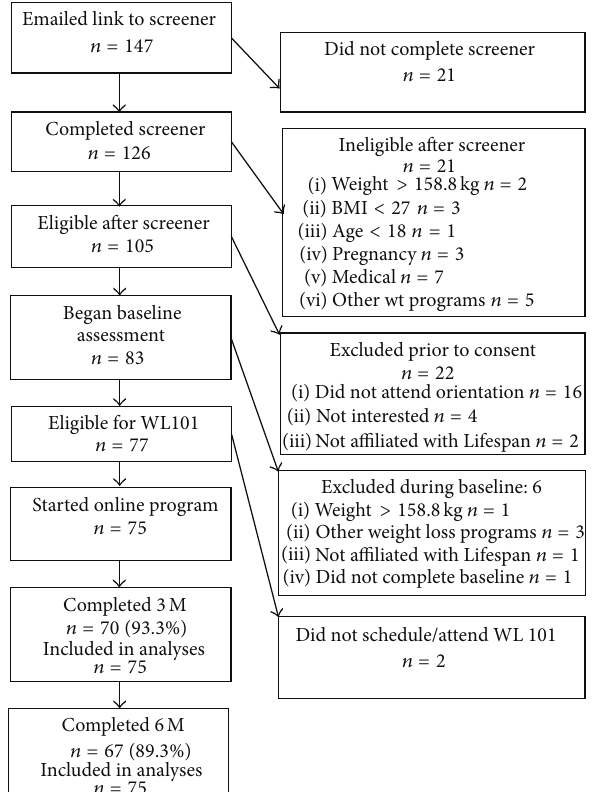
Figure 1: Participant flow through recruitment and intervention.